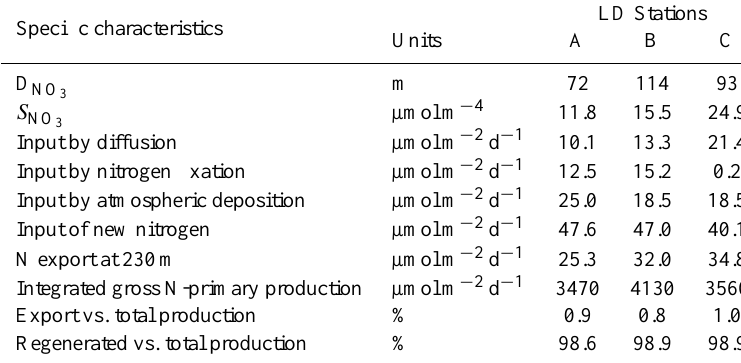
Table 4. Daily N-budget at the three LD stations A, B, and C. Specific